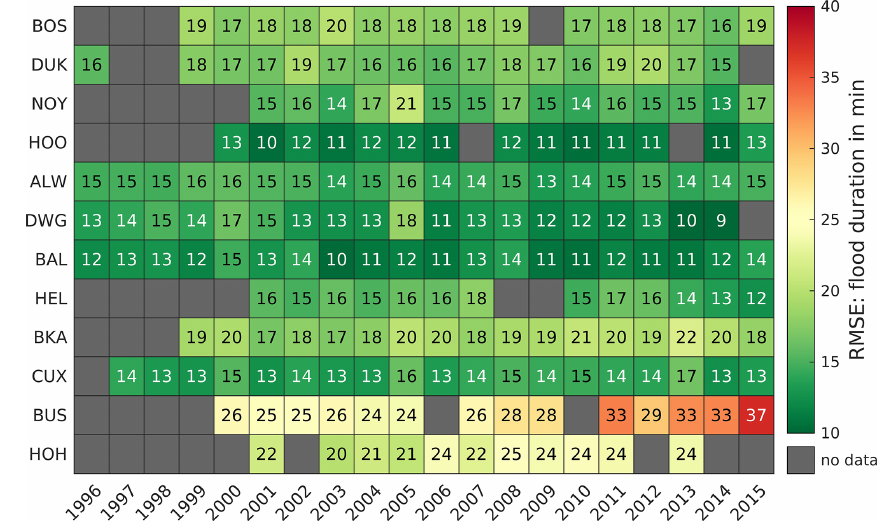
Figure 12. Root mean square error (RMSE) of the flood duration in minutes between 1996 and 2015 at representative gauges.